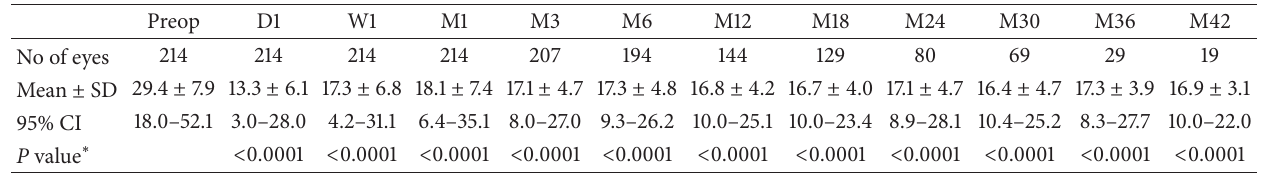
Figure 9: Box-plot representation of IOP values over 48 months of follow-up. Table 1: Pre- and postoperative intraocular pressure measurements (mmHg).